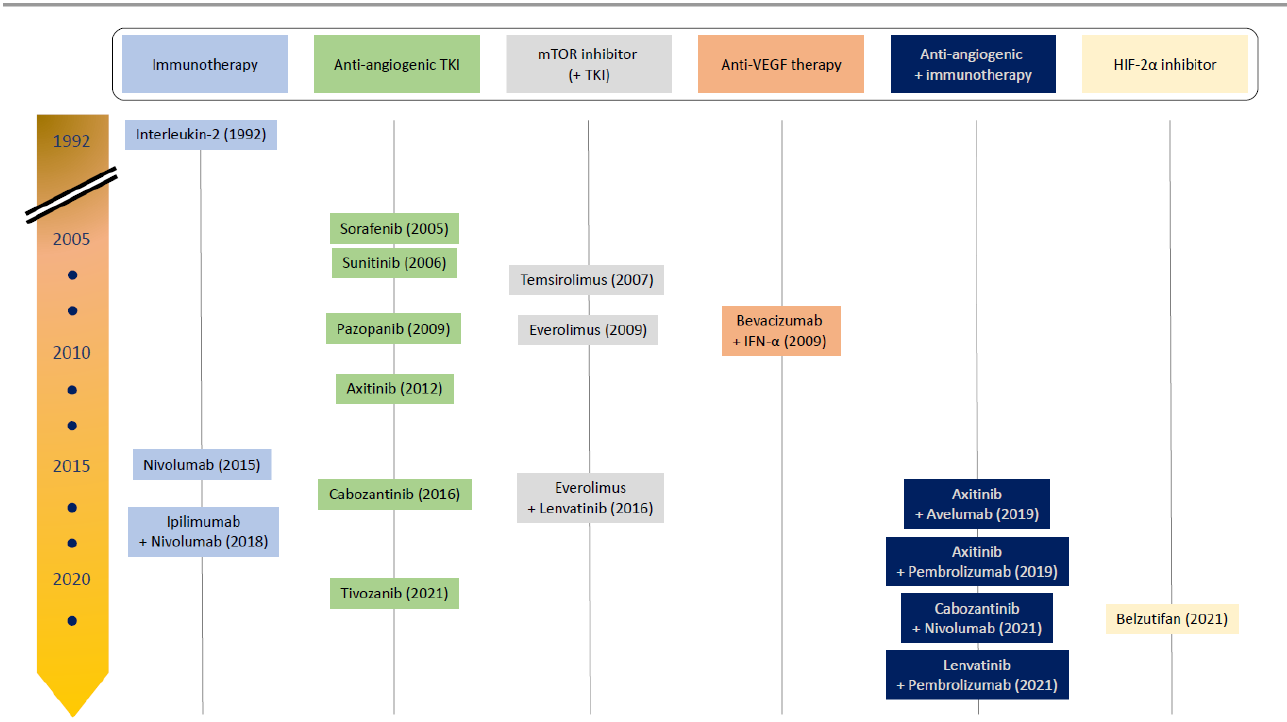
Figure 1. Timeline of US Food and Drug Administration drug approvals for advanced-stage renal cell carcinoma. Initial clinical success was seen with targeted therapies affecting angiogenesis and PI3K pathways in 2005, until 2015 when the first immune checkpoint inhibitor was approved for use. Within the last five years, more successes have been experienced with combination therapies, suggesting therapeutic synergy. Belzutifan is only approved for von Hippel–Lindau-related clear-cell renal cell carcinomas. Abbreviations: IFN- α = interferon alpha; TKI = tyrosine kinase inhibitor; mTOR = mammalian target of rapamycin; VEGF = vascular endothelial growth factor; HIF-2 α = hypoxia-inducible factor-2 α .